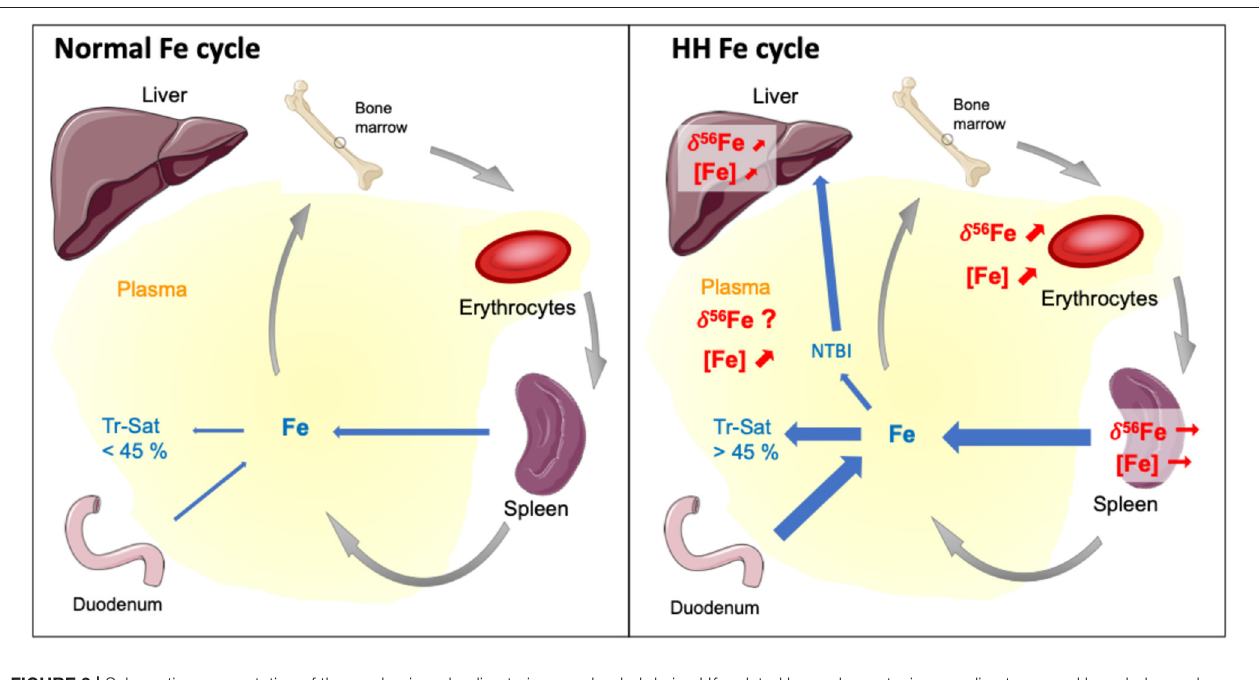
FIGURE 3 | Schematic representation of the mechanisms leading to iron overloaded during H fe -related hemochromatosis according to general knowledge and conclusions of this study. Tr-Sat and NTBI stand for Transferrin saturation level and Non-Transferrin Bond Iron, respectively. In normal situation, the regulation of hepcidin expression allows control of Tr-Sat ( < 45%). Genetic hemochromatosis results in iron release in plasma from the dietary absorption through the duodenum and the recycling of erythrocytes by macrophages during the erythrophagocytosis process. The Tr-Sat increases above 45%, leading to the appearance of abnormal biochemical form of iron in plasma, the NTBI. The present study shows that Fe concentrations and isotope compositions of liver and erythrocytes, but not spleen, increase in a mouse model of HH compare to wild type. Our results suggest that the altered erythrocyte Fe isotope composition of HH patients originates from the disease and is aggravated by the cure. The heavy isotopes iron accumulation in liver could be related to the NTBI whose role should be confirmed by further